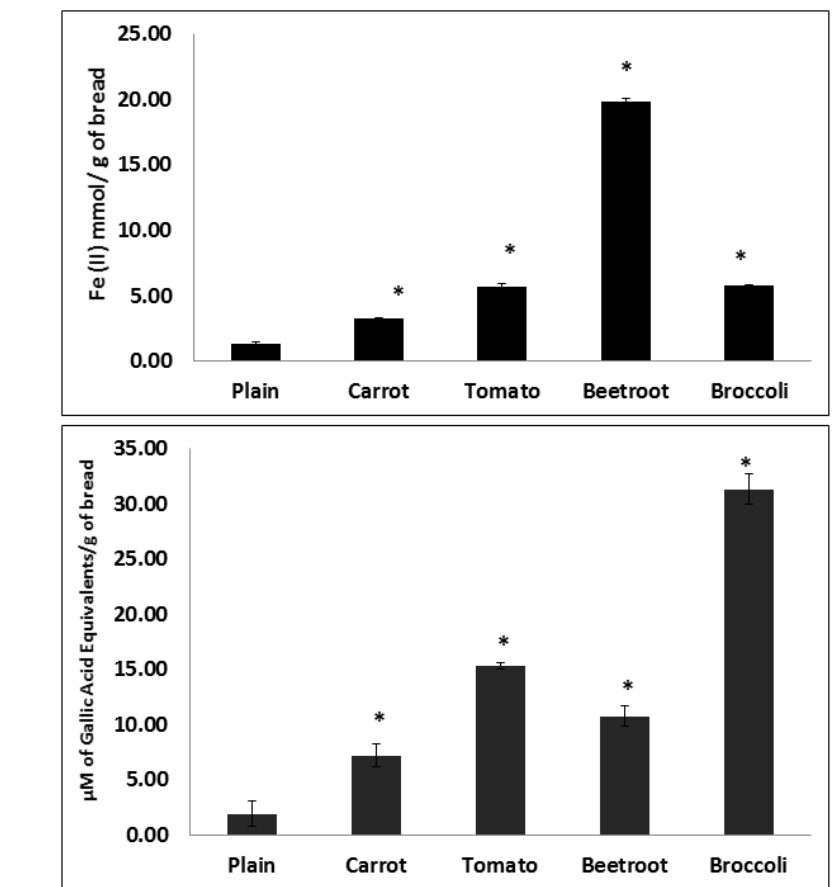
Figure 2. Antioxidant capacity of breads measured using FRAP ( A ) and HORAC ( B ) assays. FRAP: Ferric Reducing Antioxidant Potential; HORAC: Hydroxyl Radical Averting Capacity. Columns with asterisks are significantly different to the plain bread ( p < 0.05; n = 4). Error bars are standard errors.